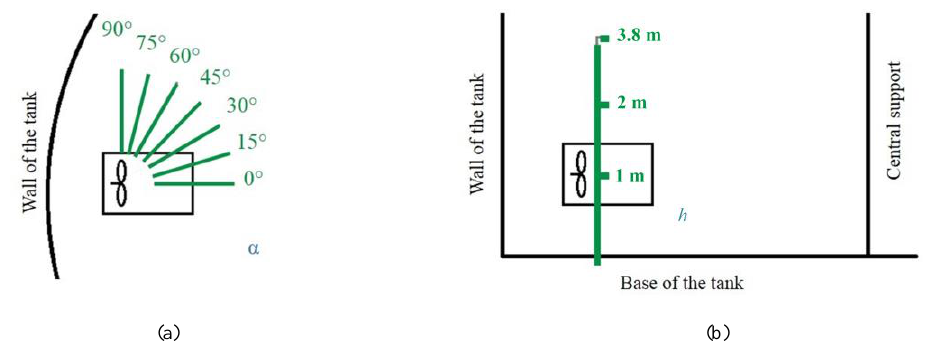
Fig. 7. Geometrical parameters of the mixers and corresponding values used in the CFD simulations: (a) angle of axis of the mixer; (b) height of the axis of the mixer. For the model-based sensitivity analysis the rheology of the fluid was adapted to a real substrate mixture with 12 wt % dry matter content, while the consistency factor and flow index of the power law conditions were set to the values of 16.77 Pa·s n and 0.35, respectively. As suitable simplification already used in the CFD model for scaled-down laboratory digester [15], the k- ω model was applied to contemplate the wall boundary effects. On the wall and bottom of the tank, no-slip conditions were set, whereas the fluid surface on the top was modelled with slip boundary